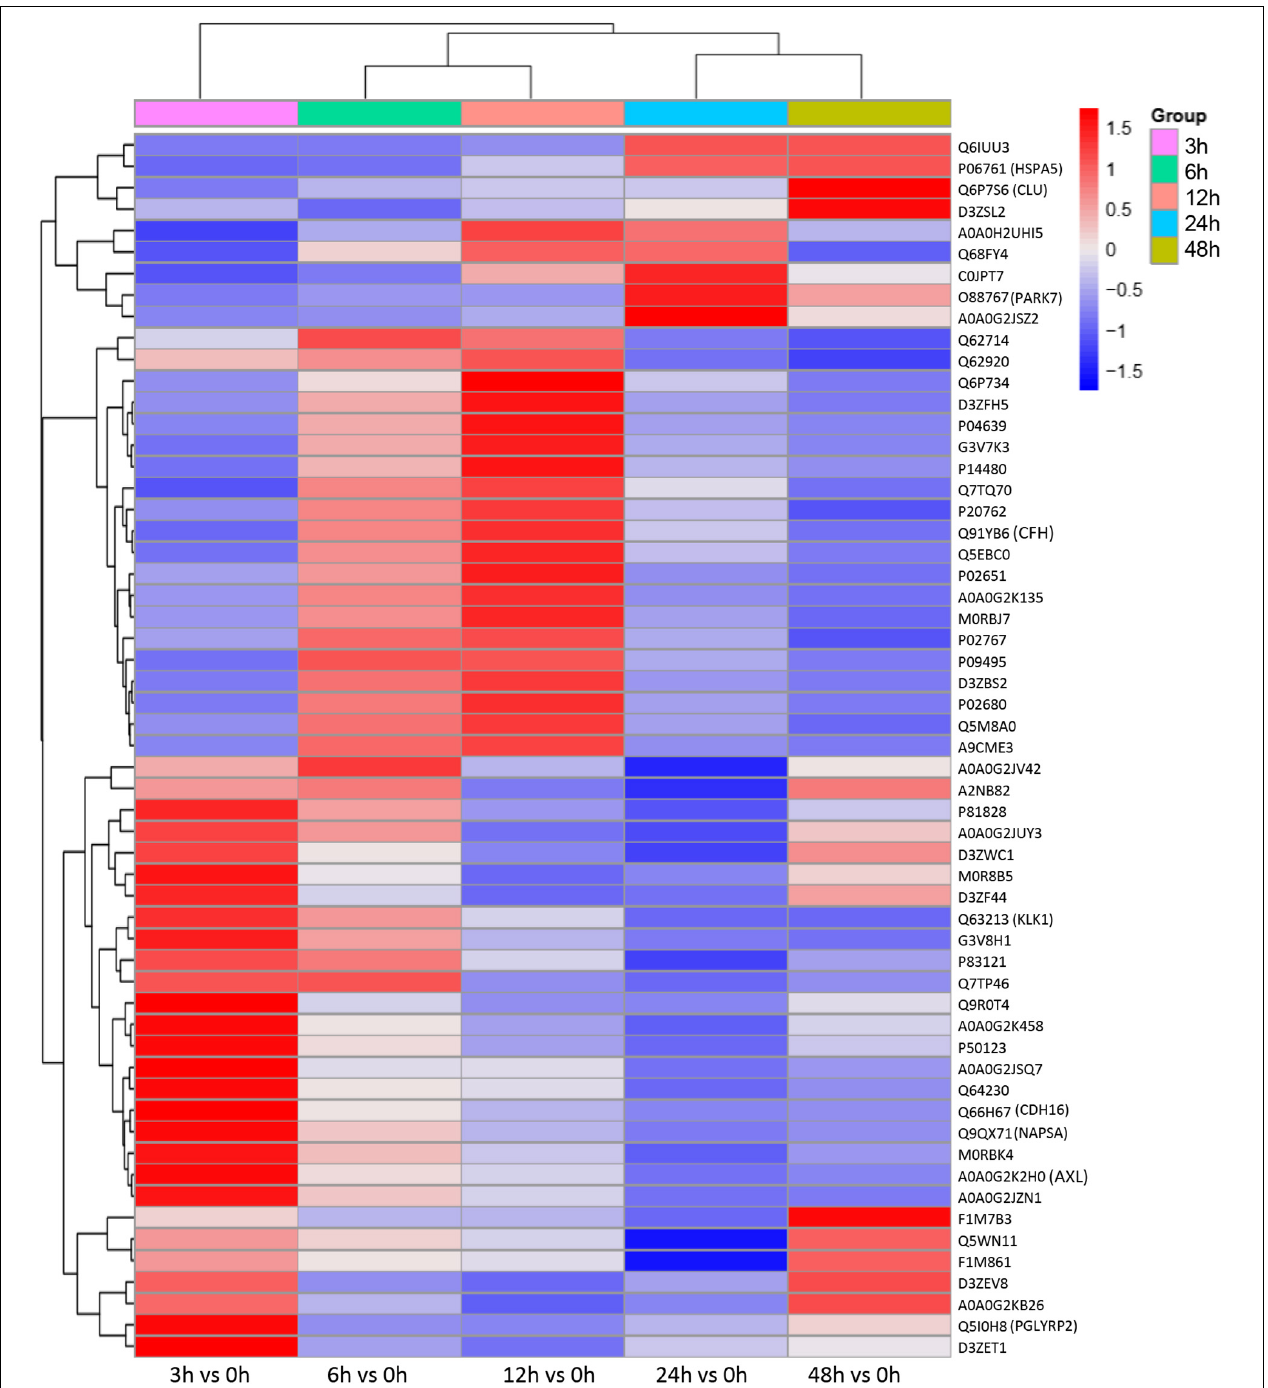
FIGURE 6 | Differentially expressed proteins with a continuous change, which began from the onset of kidney injury and lasted for the whole course of the disease, were sorted, and a heatmap showed the relative expression of these proteins in the indicated time. Protein IDs were showen in the right side of heatmap. P < 0.05.